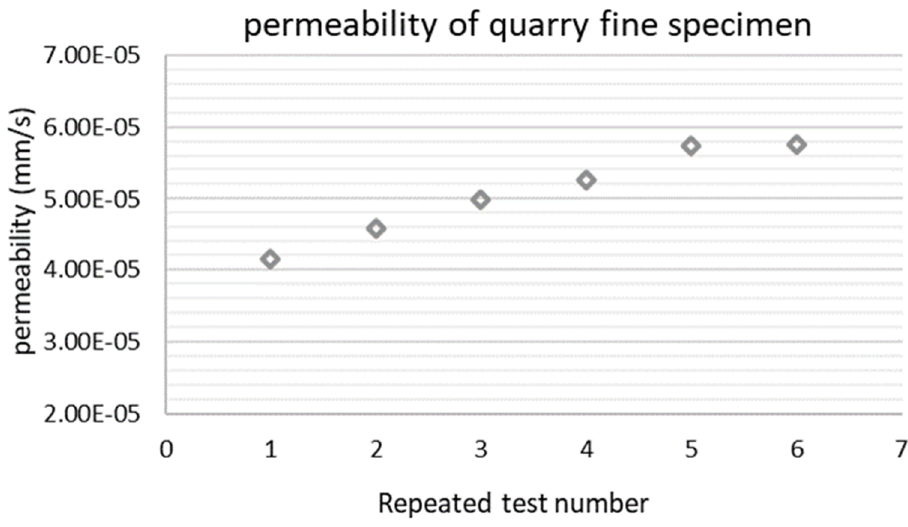
Figure 7. Permeability results of the unbound quarry fine specimen.